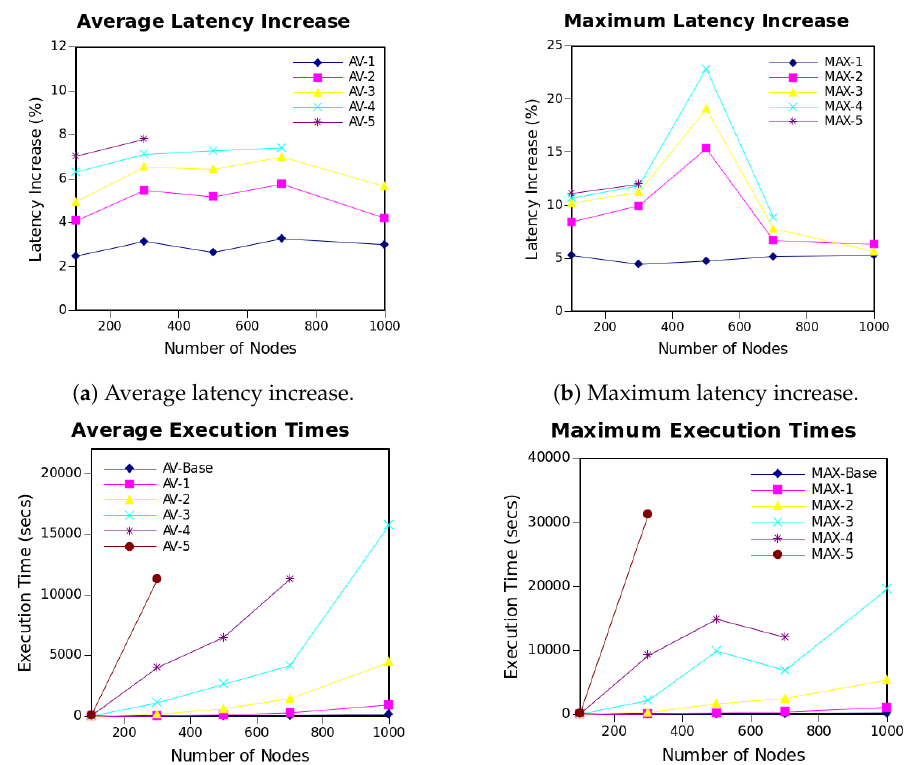
Figure 4. Average and maximum latency increase values and execution times for networks with nodes distributed according to area specified in Table